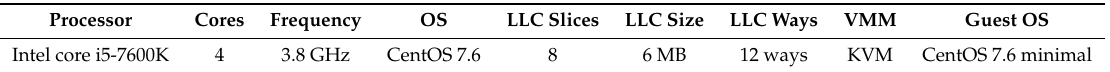
Table 1. Experimental platform